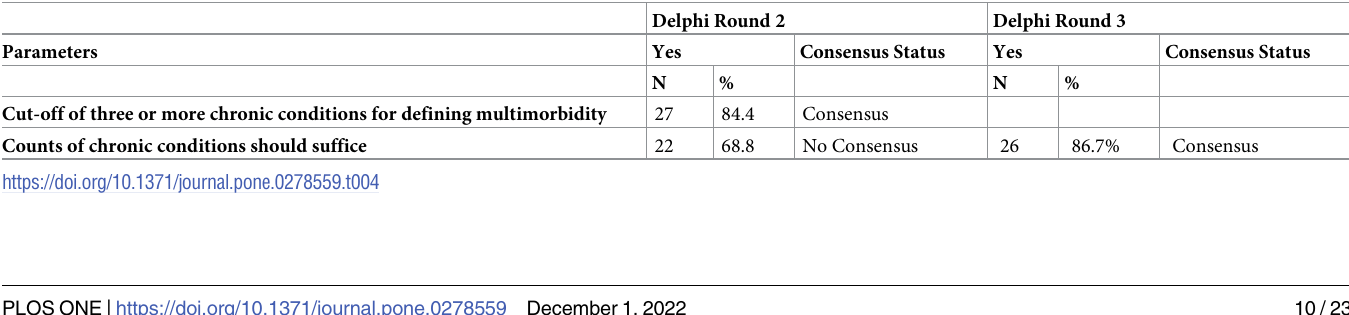
Table 4. Findings for parameters for defining